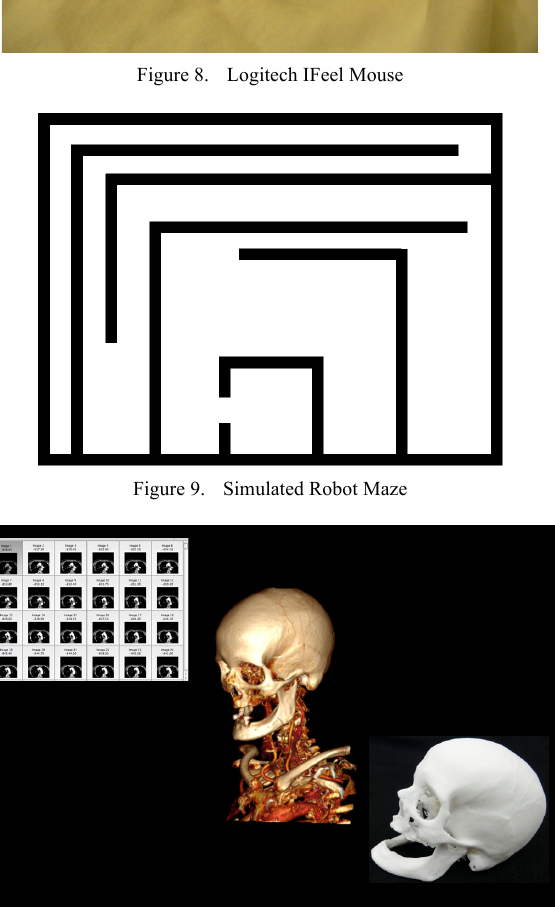
Figure 10. CT sequence, Volume Rendering, Physical